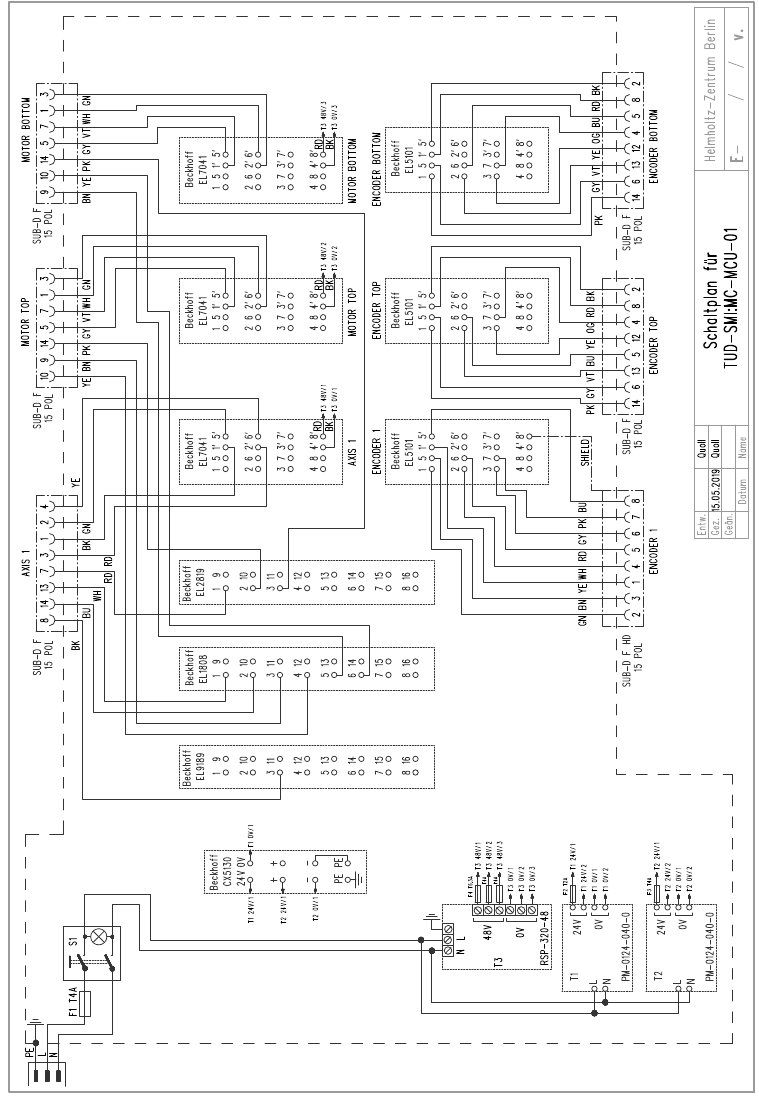
Figure 5. Circiut diagram of the motion control crate. Beside the translation stage, a two-axis goniometer is also controlled by this